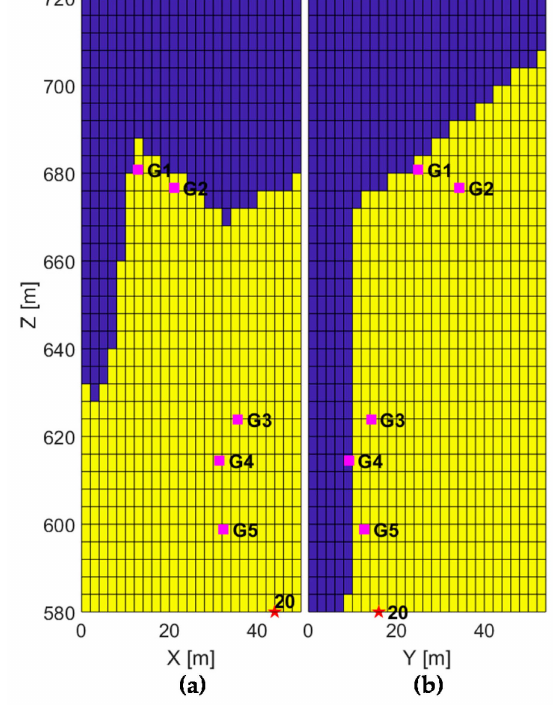
Figure 16. Location results for Fracture event 20 (Suspected fracture (outside the area)) presented on vertical slices in the front view ( a ) and the side view ( b ). The blue area is the air, and the yellow area is rock mass. Pink squares indicate the five 3C geophones projected on the slice. Red stars indicate the event locations projected on the